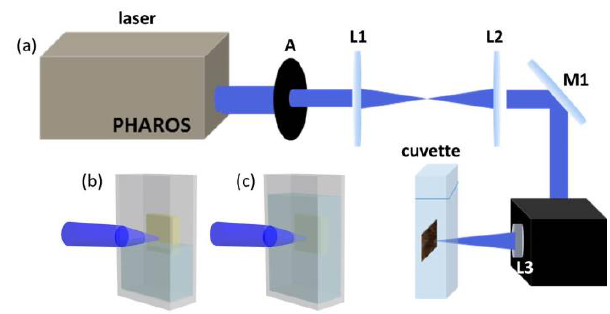
Figure 1. ( a ) The scheme of fs-PLAL (pulsed laser ablation in liquid); the relative position between the laser’s focus and liquid level in ( b ) air, ( c ) water and ethanol.